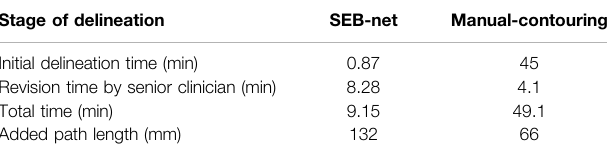
TABLE 7 | Comparison of meantime and added path length required by different methods to delineate a HaN tumor case at different stages. Stage of delineation